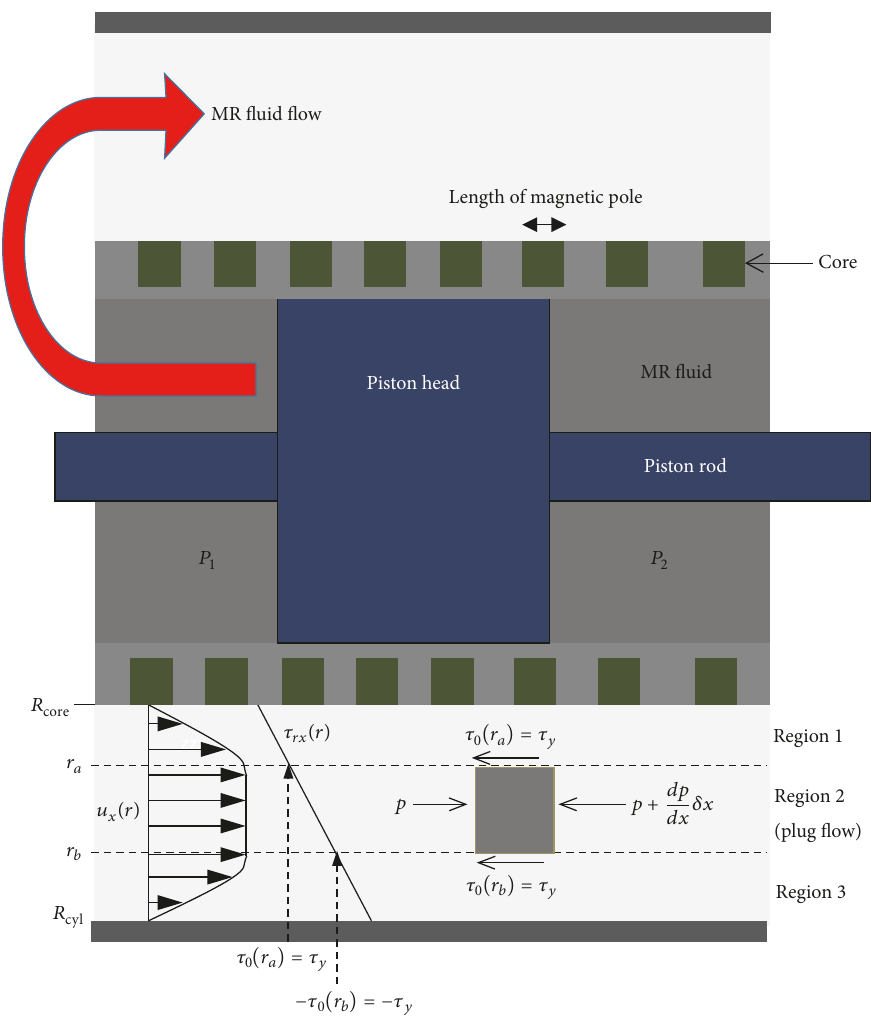
Figure 6: Incompressible viscous axisymmetric annular duct flow